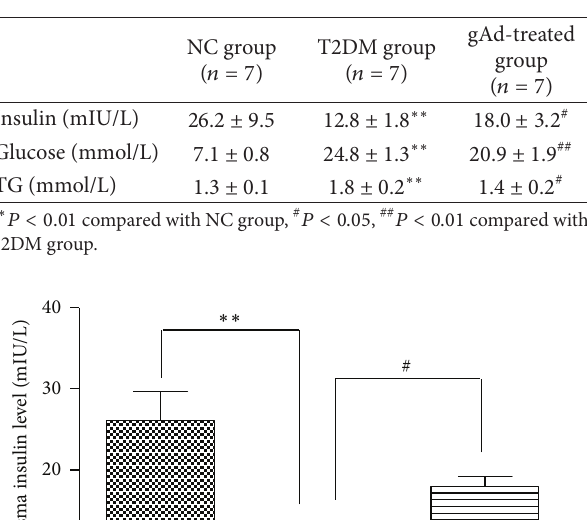
Table 1: The fasting plasma insulin, glucose, and TG levels of rats ( 𝑥 ± 𝑠 ).